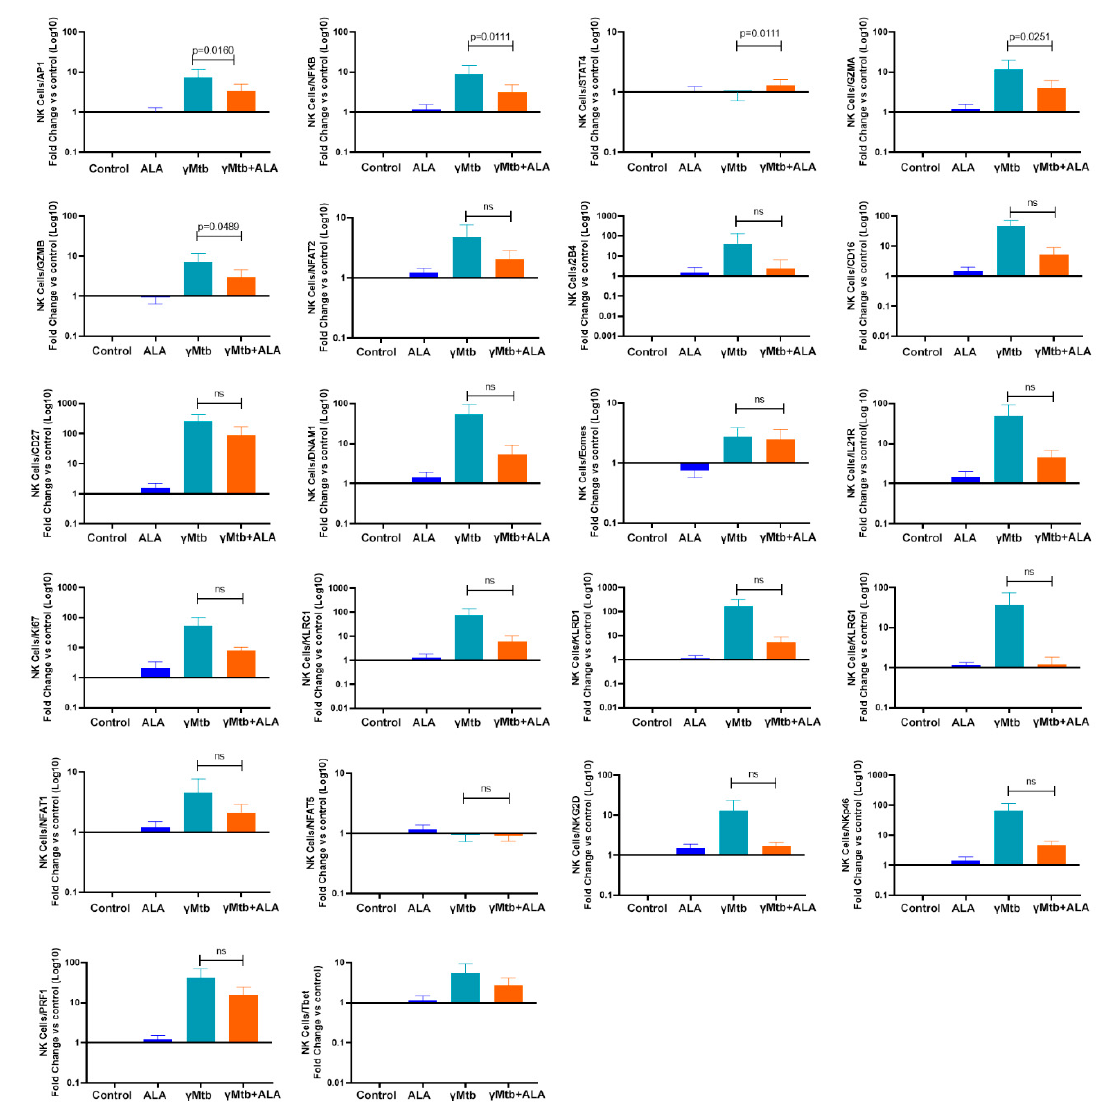
Figure 5. ALA inhibits NF- ƙ B, AP1, GZMA, and GZMB gene expression in γ Mtb -cultured NK cells. PBMCs of healthy LTBI+ donors were cultured with or without γ M tb (10 µg/mL) and in the presence or absence of ALA, as mentioned in the Methods section. After 48 h, NK cells were isolated by fl ow sorting, RNA was collected, and real-time PCR analysis was performed to determine various signaling molecules and transcription factors. PBMCs from six LTBI+ donors were used for this experiment. Paired t -tests were used to compare the di ff erences between untreated and treated PBMCs from the same samples. The signi fi cant p values are shown ( p < 0.05); ns: not signi fi cant, p > 0.05.